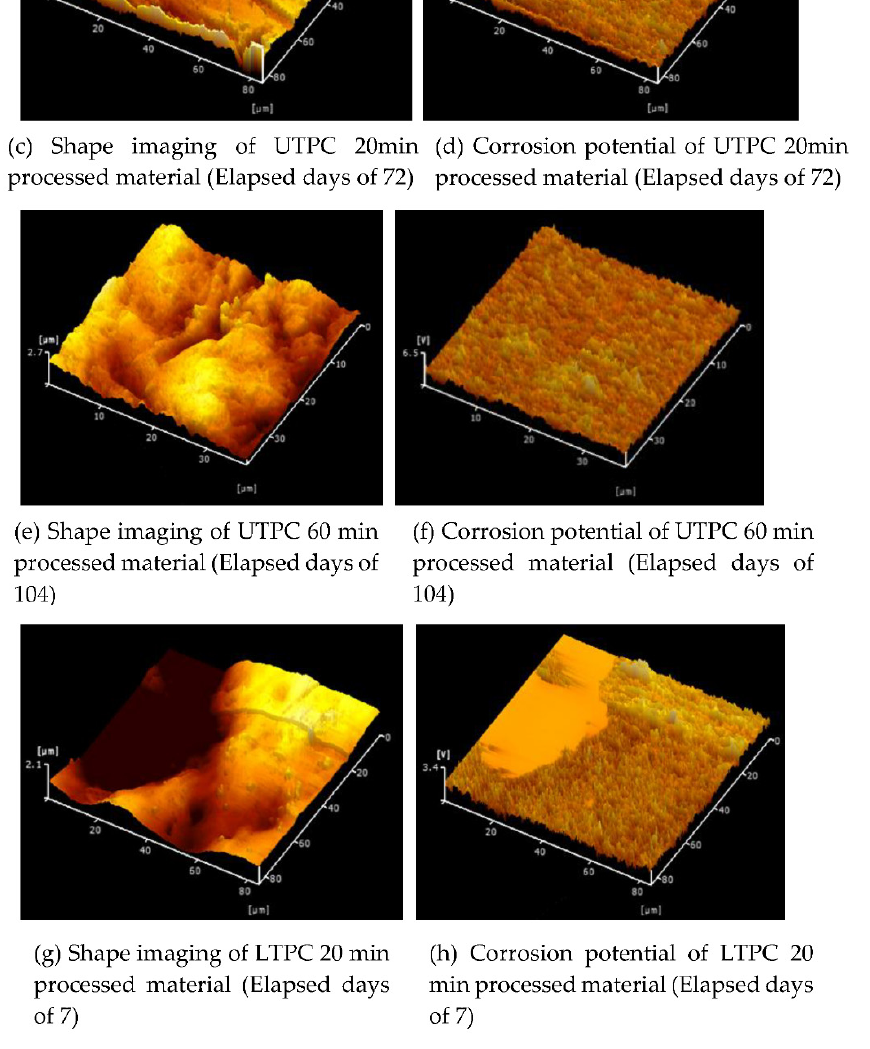
Figure 9. Results of shape imaging and corrosion potential measurement of UTPC and LTPC processed material by Kelvin force probe microscope (KFM).